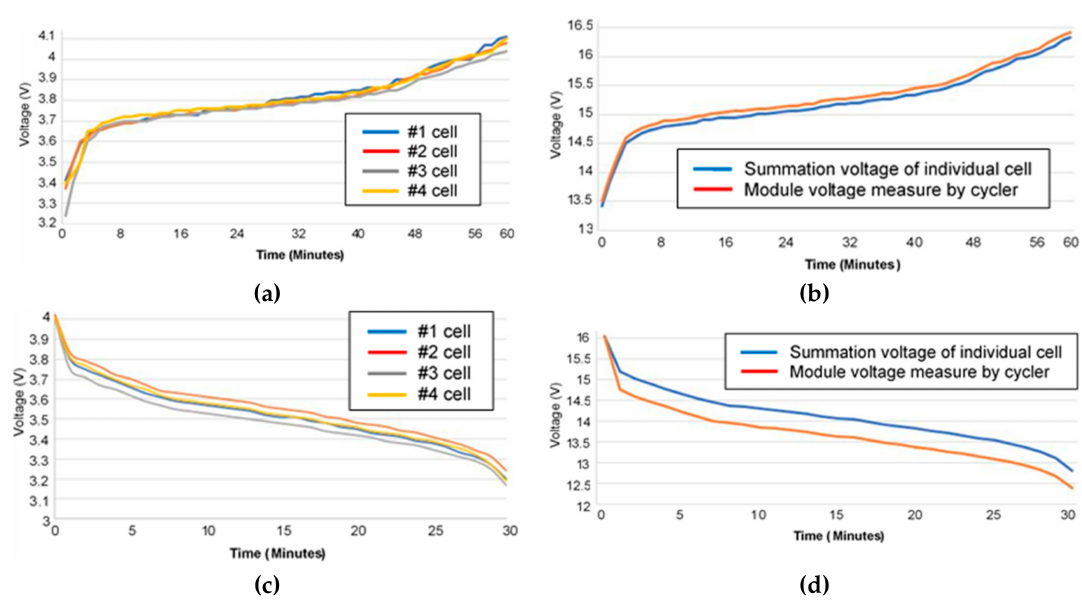
Figure 9. Examples of cell and module charging / discharging curves from tests: ( a ) Individual cell voltage in 20 A charging; ( b ) module voltage in 20 A charging; ( c ) individual cell voltage in 40 A discharging; ( d ) module voltage in 40 A